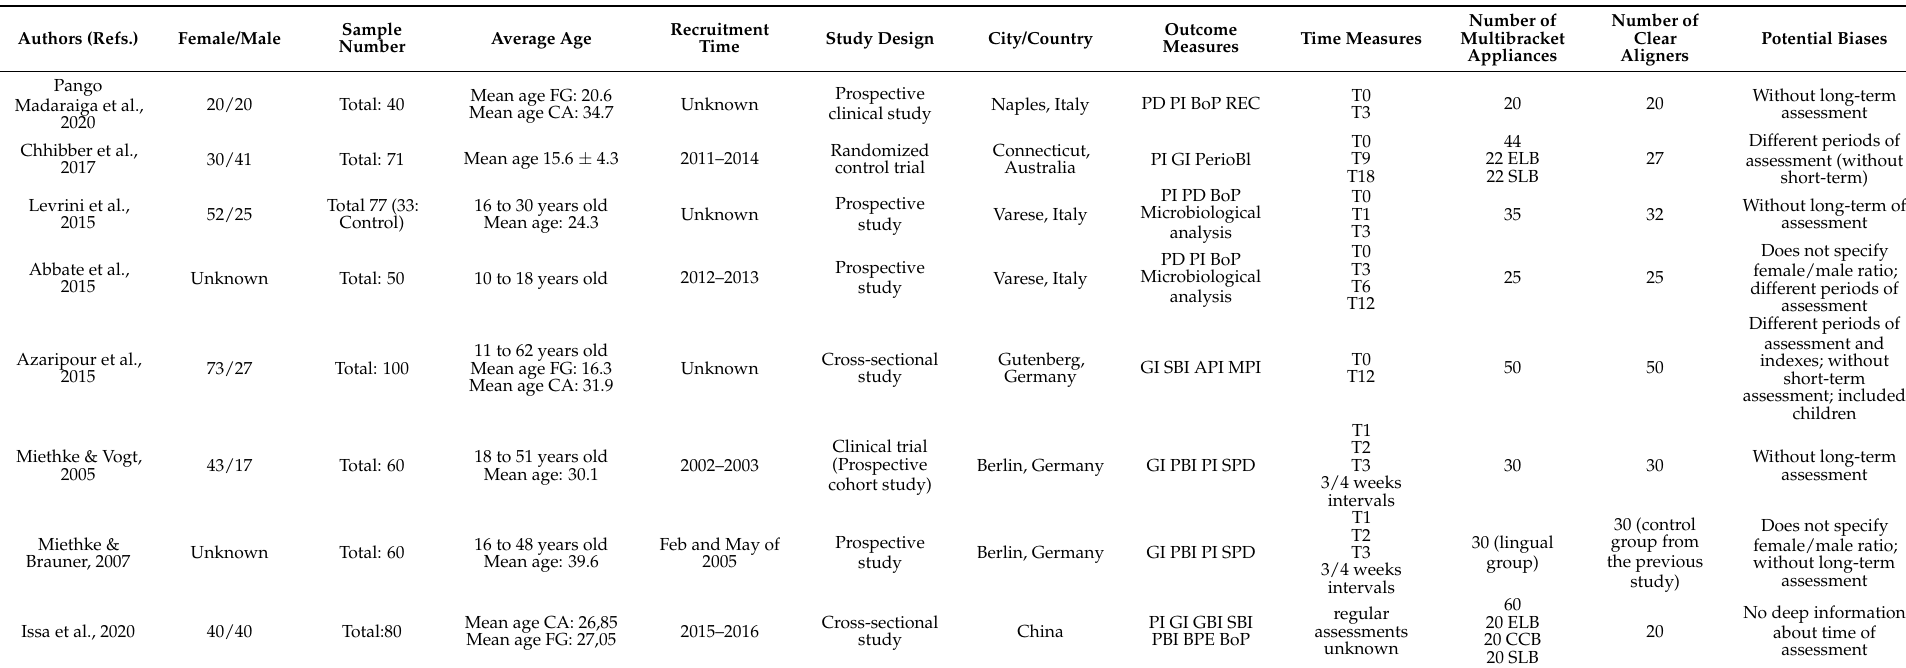
Table 3. Characteristics of the eligible